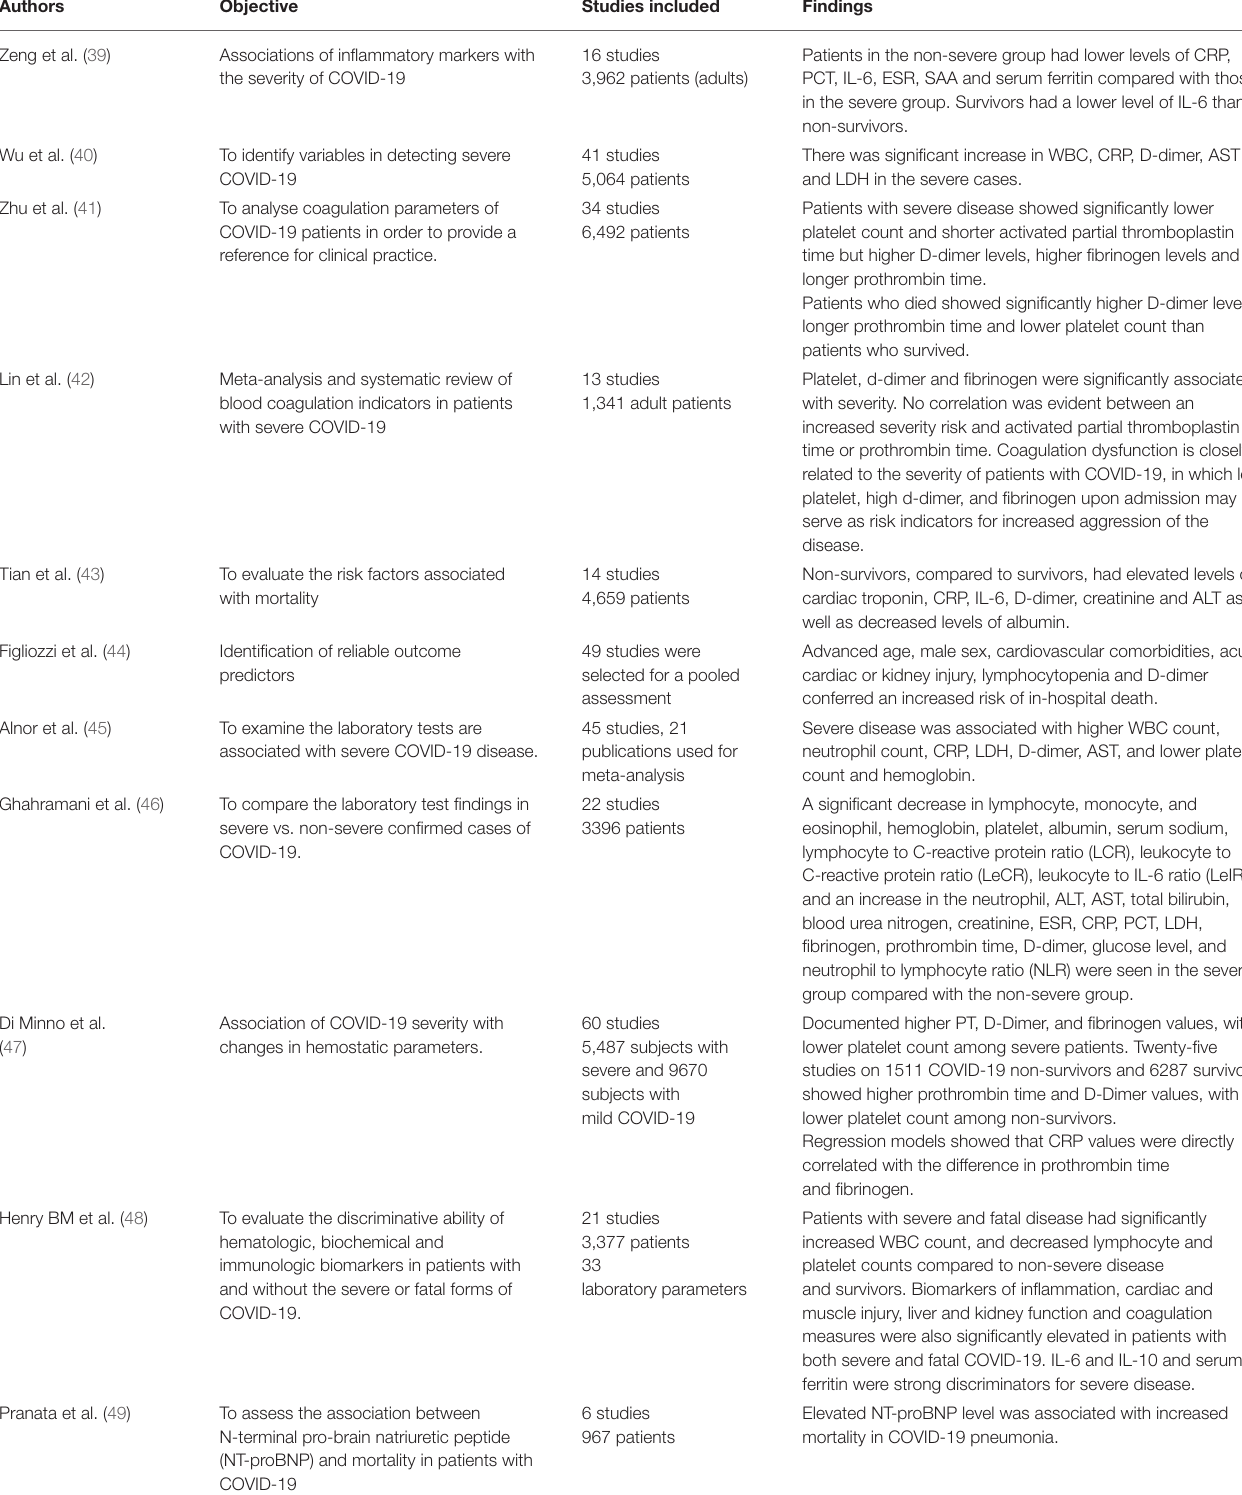
TABLE 2 | Summary of the meta-analyses and systematic reviews investigating the role of biomarkers in